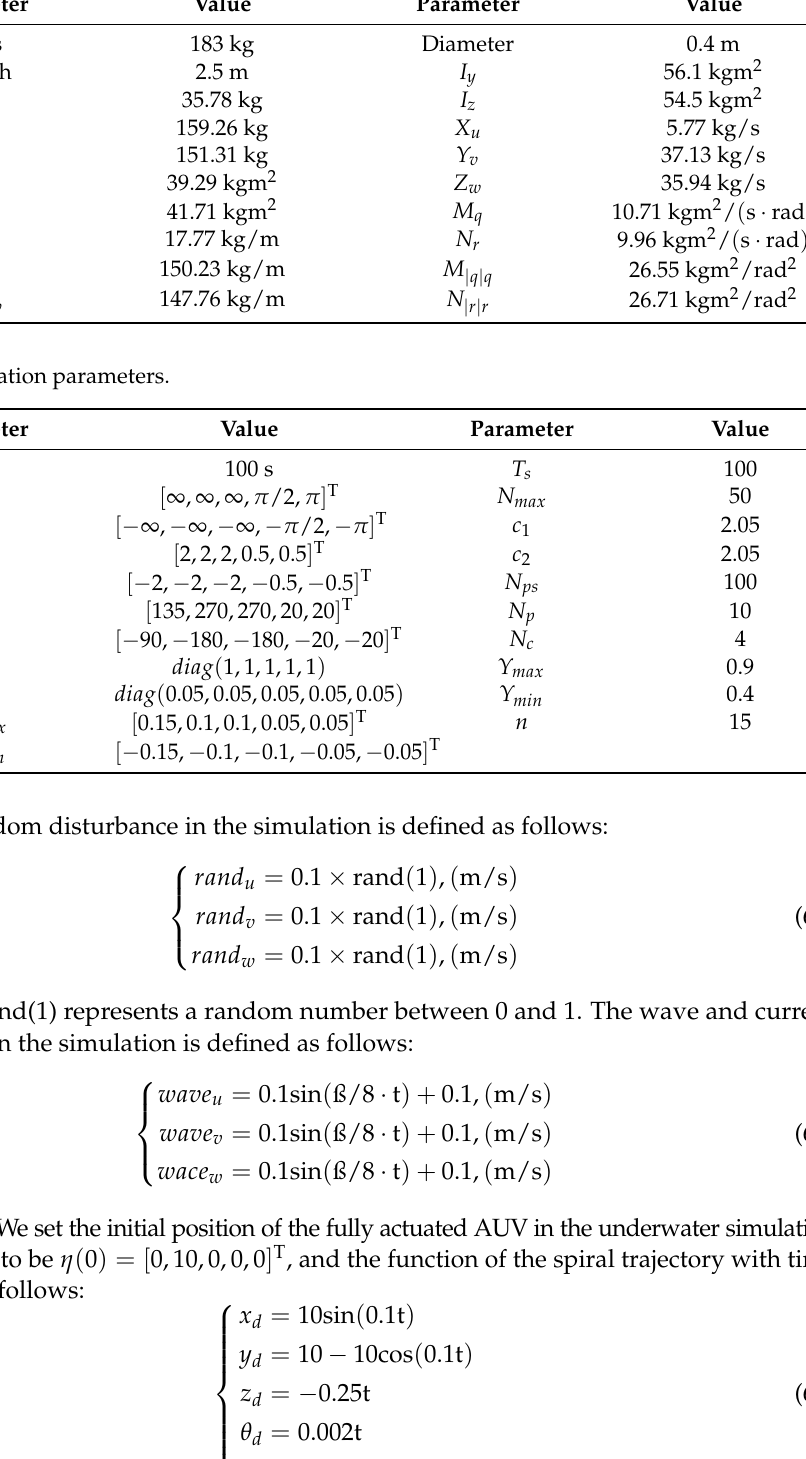
Table 1. Basic parameters and hydrodynamic coefficients of AUV. Parameter